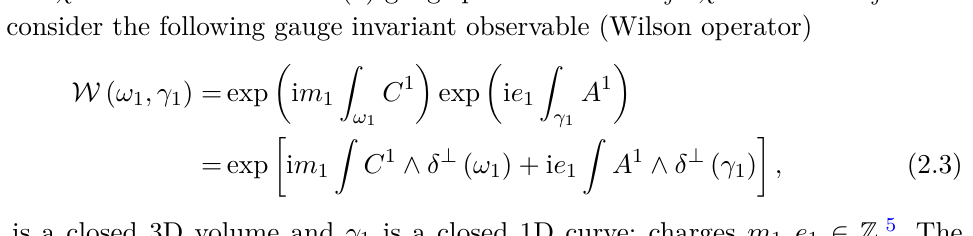
it in different 3 D spaces with a fixed 4 th